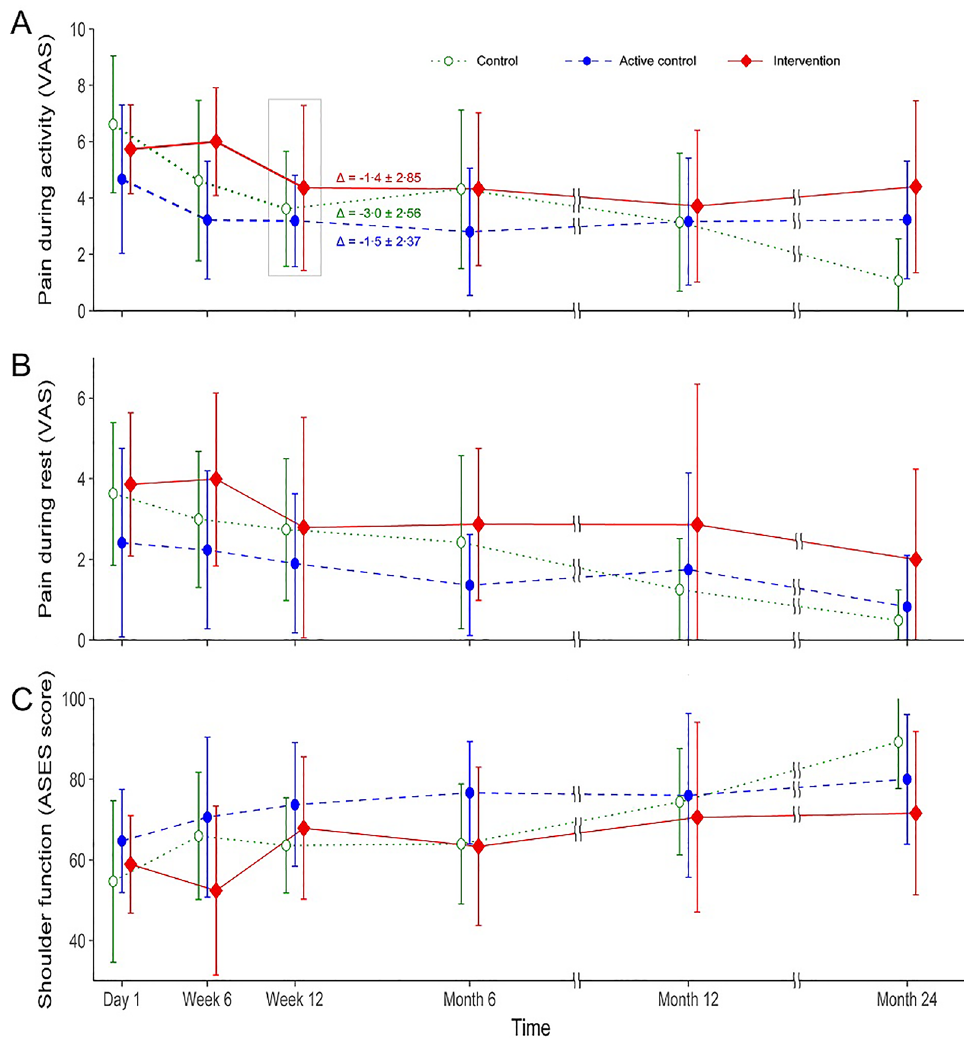
Figure 2. Mean values of pain during activity ( A ) and rest ( B ) assessed by visual analog scale (VAS) and shoulder function ( C ) by American Shoulder and Elbow Surgeons (ASES) score are shown by group and time. The primary outcome, change (Δ) in pain during activity from baseline to 3 months after injection, is noted at the ‘Week 12’ point of the designated group. Whiskers indicate standard